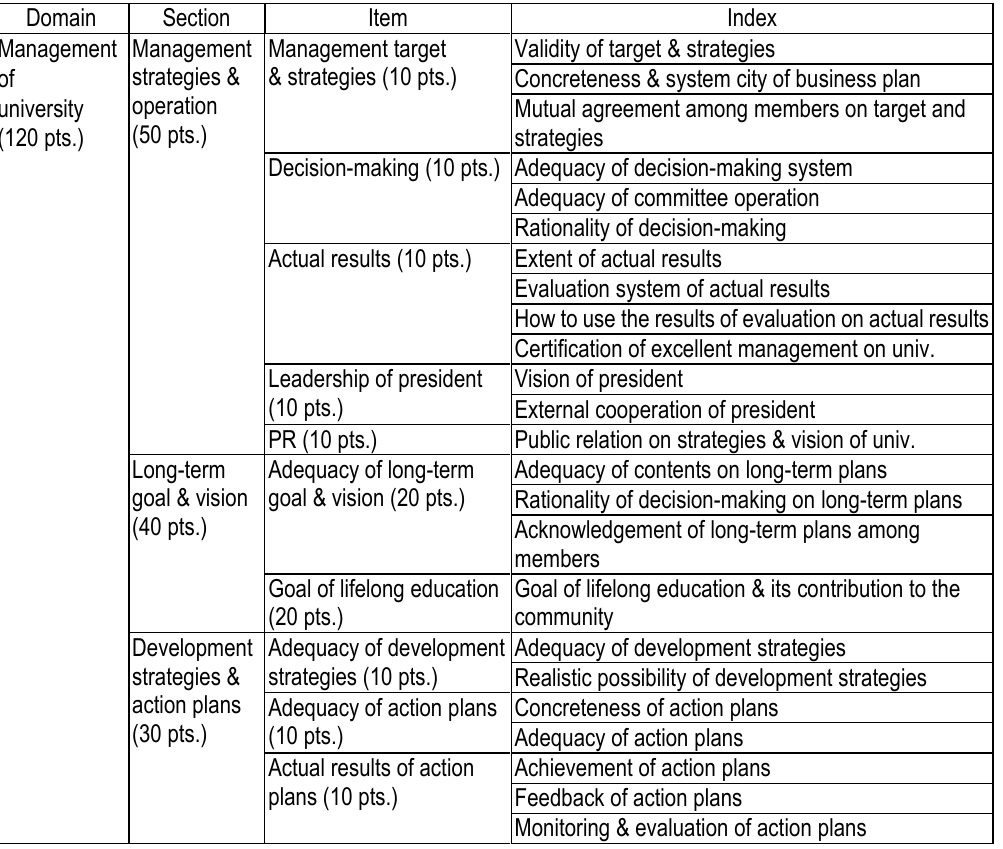
Table 1. Management of university